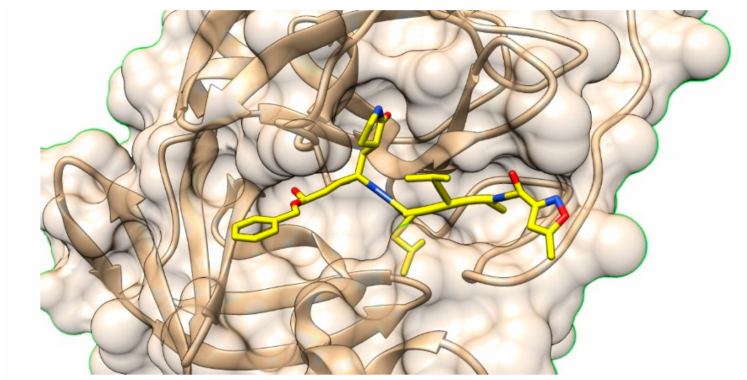
Figure 8. Crystal structure of the SARS-CoV-2 main protease in complex with ligand N3 (PDB code 7BQY). 30. Stalobacin I: The Newest Member of the Remarkable Family of Peptide-Based Antibiotics Highlighted by Paula A. C.